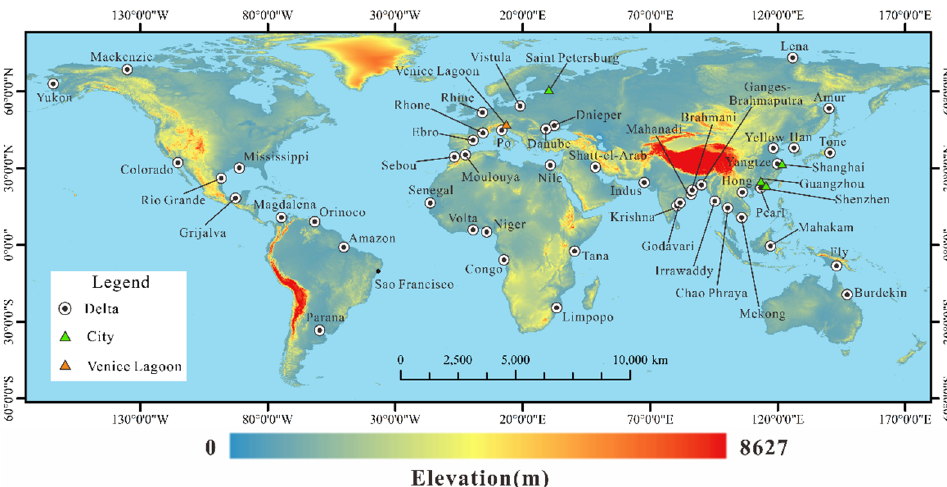
Figure 1. Map of the spatial distribution of the 48 most critical river deltas worldwide considered here [126] . The base map is a global map of lands surface elevation [taken from the GEBCO_2020 Grid [127] ] with a spatial resolution of 15 arc s.